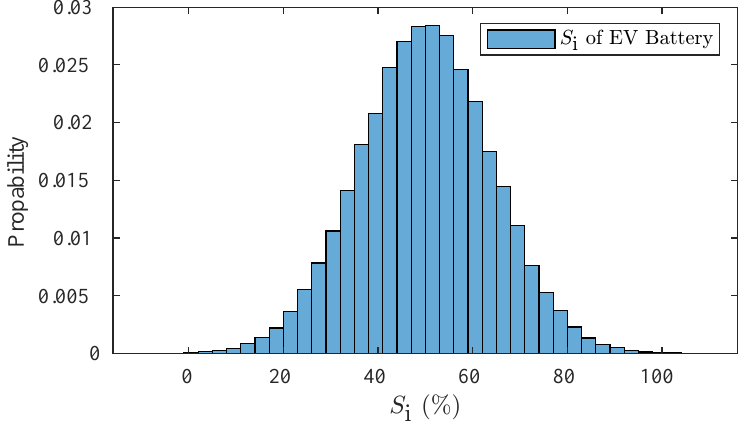
Figure 5. Distribution of the initial SOC, S i , where the normal distribution is